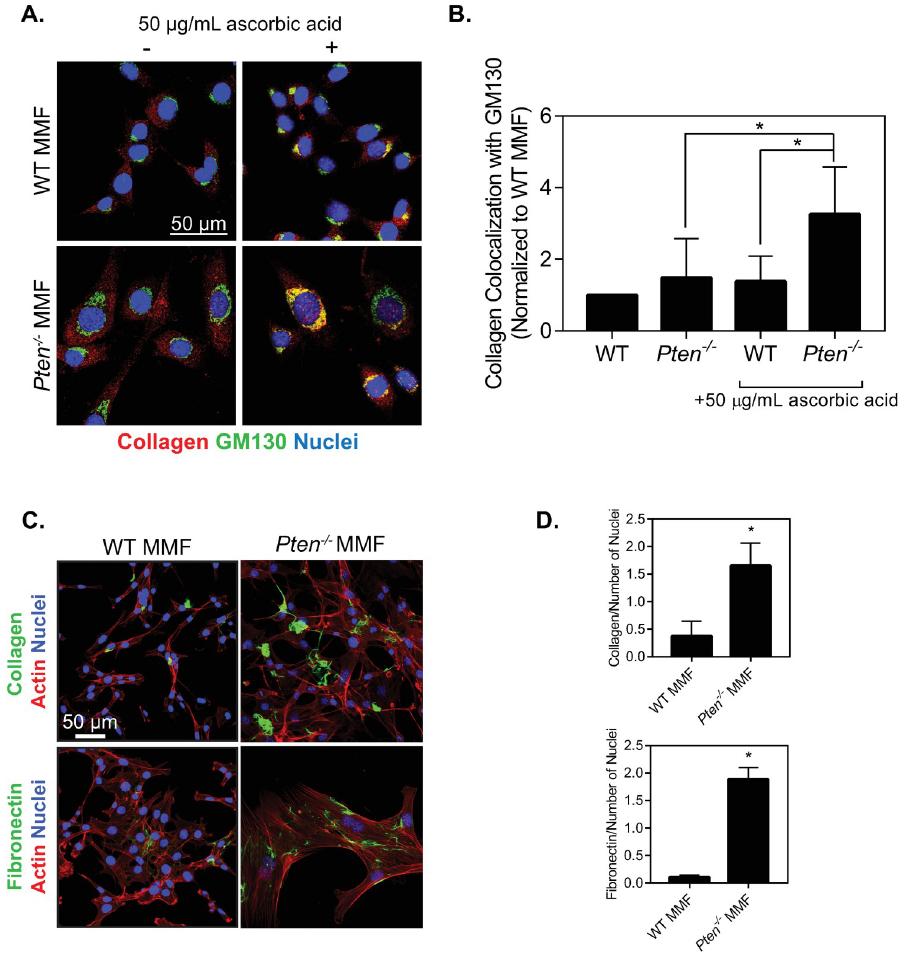
Fig 3. Pten knockout alters collagen shuttling and fibrillogenesis. (A) Immunofluorescence images of WT and Pten -/- MMF plated for 24 hours and cultured with or without 50 μ g/mL ascorbic acid for 1 hour, then fixed and stained for collagen, GM130, and nuclei. (B) Quantification of collagen colocalization with GM130, determined by Manders’ correlation coefficient and normalized to the WT condition. n = 5+SD. � p < 0.05. (C) Immunofluorescence images of cells incubated with fluorescently labeled collagen and fibronectin for 24 hours, then fixed and stained for actin and nuclei. (D) Quantification of the area of each image covered by collagen fibers normalized to number of nuclei in each image. (E) Quantification of the area of each image covered by fibronectin fibers normalized to number of nuclei in each image. n = 3+SD. � p < 0.05 relative to